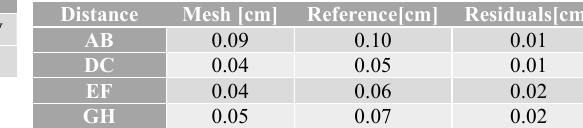
Table 2 . Distances extracted from the mesh and from the object (reference) and the computation of the